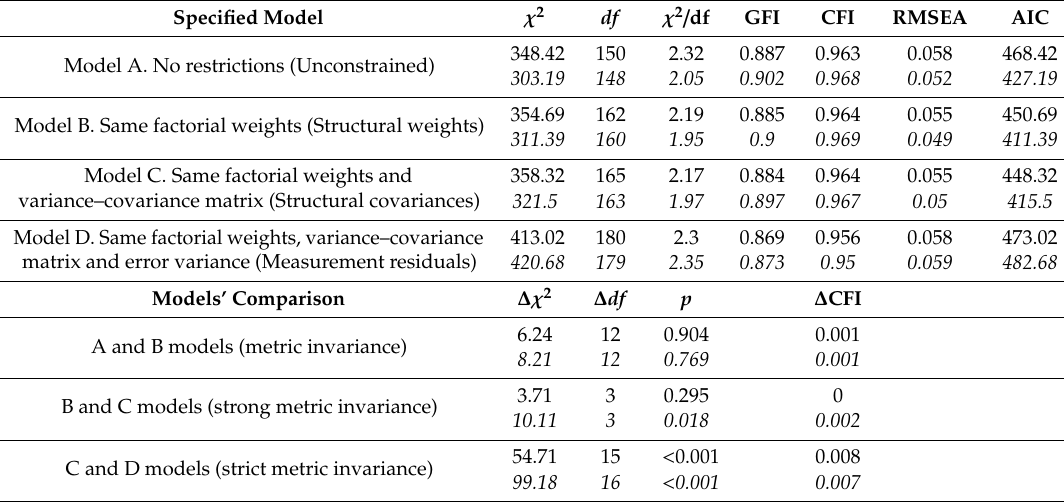
Table 5. Goodness of fit indexes according to